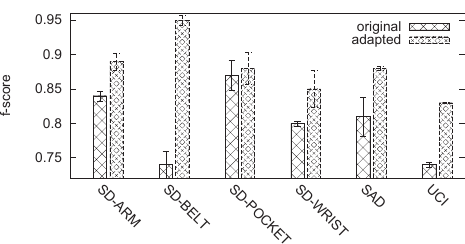
Figure 5: F-score improvement by dynamically and automatically incorporating accelerometer